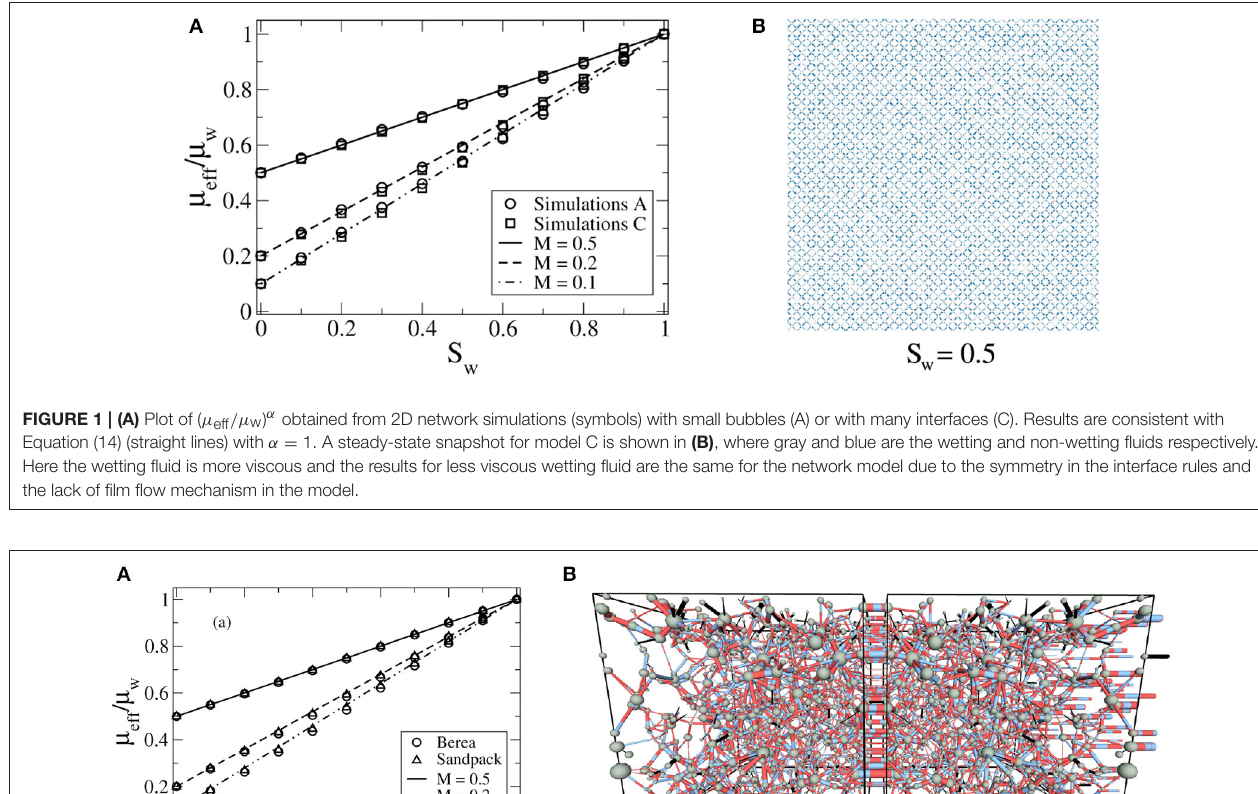
1 when compared with Equation (14). =